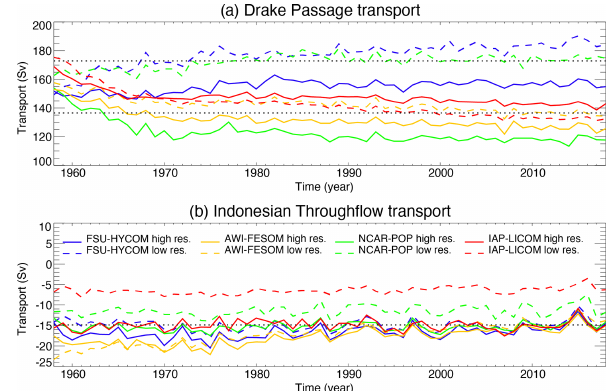
Figure 16. Modeled annual mean volume transport of the ACC through the Drake Passage and of the Indonesian Throughflow (ITF) from the Pacific to Indian Ocean. The dotted lines in (a) repre- sent the observational range between the canonical transport value (134Sv) based on the ISOS program and 173Sv based on cDrake observations. The dotted line in (b) is the observed ITF transport value (15Sv) based on INSTANT